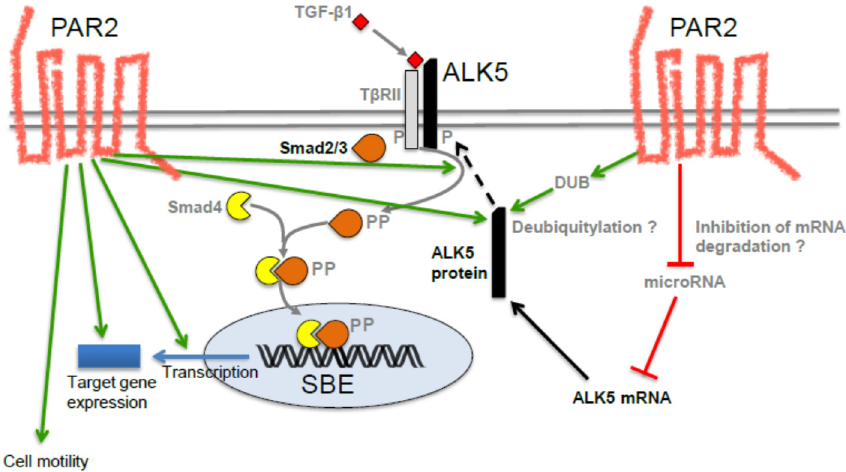
Figure 1. Cartoon showing potential mechanisms of the PAR2-TGF- β /ALK5 interaction. In the left part of the figure, the various effects of PAR2 on TGF- β signaling are indicated by green arrows such as a rise in ALK5 protein, R-Smad phosphorylation, Smad-mediated transcription, target gene expression and cell motility. In the right part, possible but as yet unproven mechanisms are shown that may cause an increase in ALK5 abundance, such as deubiquitylation (eventually resulting in ALK5 protein half-life extension) or inhibition of an ALK5-targeting microRNA. Stimulatory interactions are indicated by green arrows and inhibitory interactions by red lines. Anterograde transport of ALK5 protein to the cell surface is marked by a black stippled arrow. P, phosphate residue; SBE, Smad binding element; DUB, deubiquitylating enzyme.